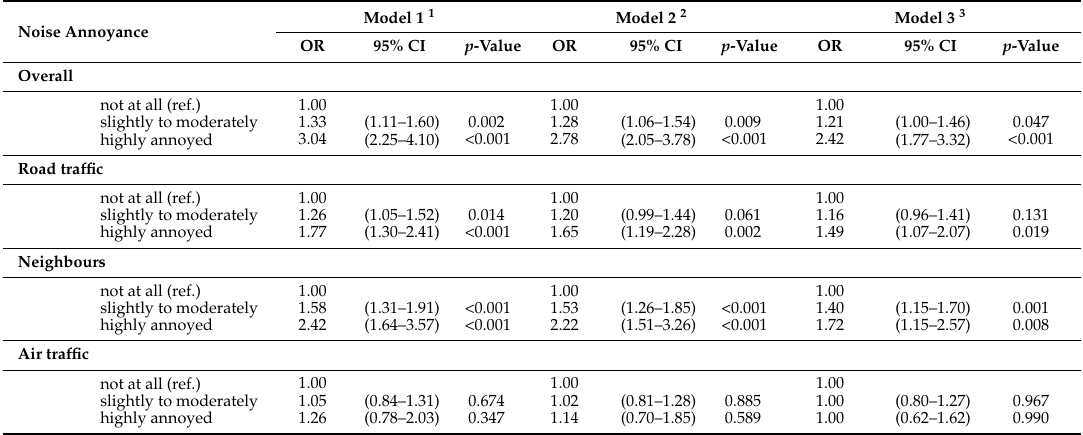
Table 3. Odds ratios of impaired mental health by noise annoyance levels and noise sources in